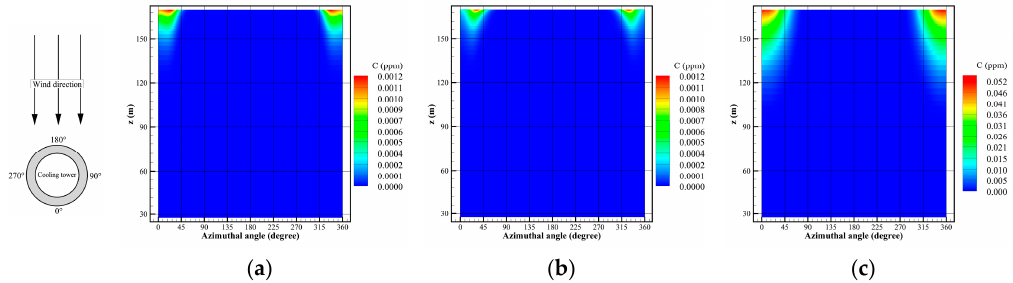
Figure 14. Comparisons of the pollutant concentration distribution at the inner shell of cooling tower: ( a ) RANS; ( b ) URANS; ( c ) LES.